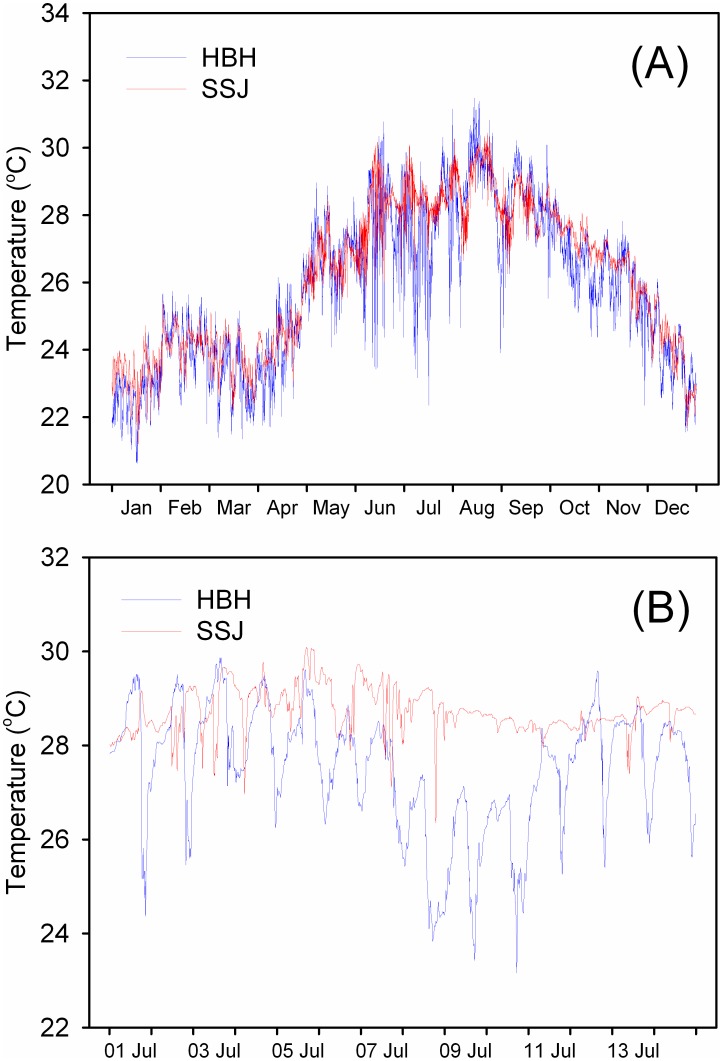
Temperature variation of seawater in the two study regions.Record of seawater temperature measured every 10 min in the upwelling (Houbibu, HBH) and control (Siashuiku, SSJ) regions inhabited by the corals from January–December 2011 (A). Subset of the temperature record between July 1 and July 14 (B) shows the temperature fluctuation in HBH.